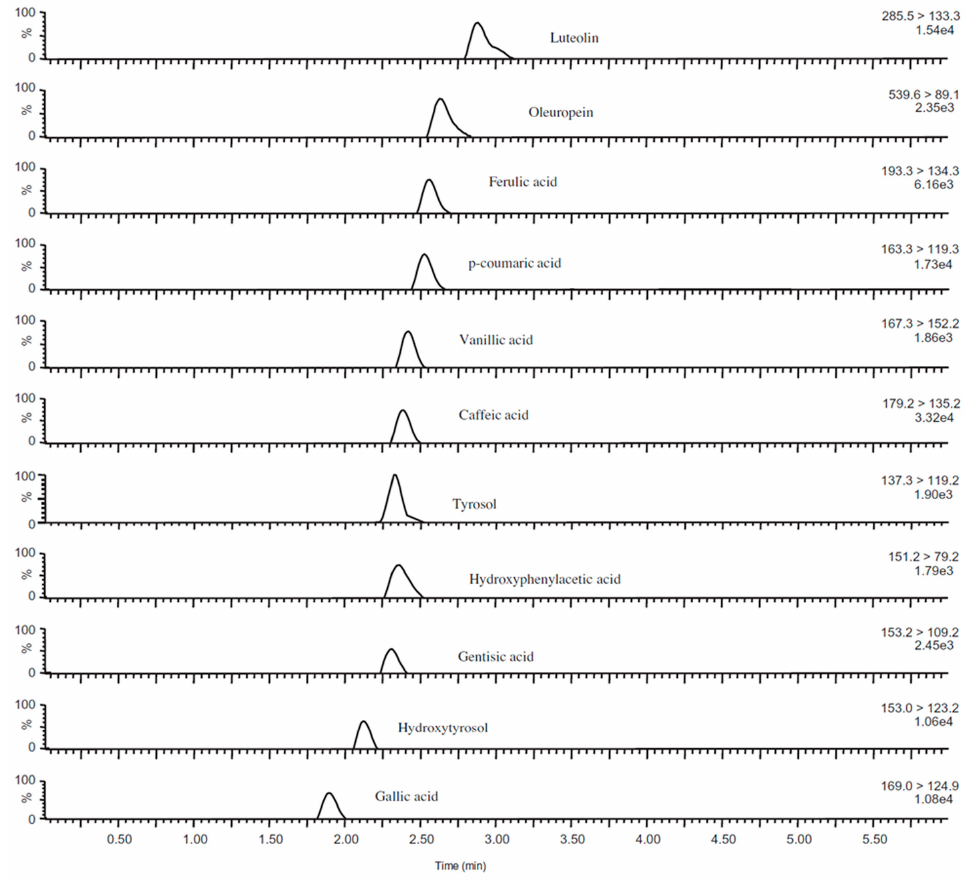
Figure 21. UHPLC-MS/MS chromatograms obtained from an olive oil spiked with the target compounds at 500 μ g/L. Reproduced with permission from [65]. Copyright Elsevier, 2012.